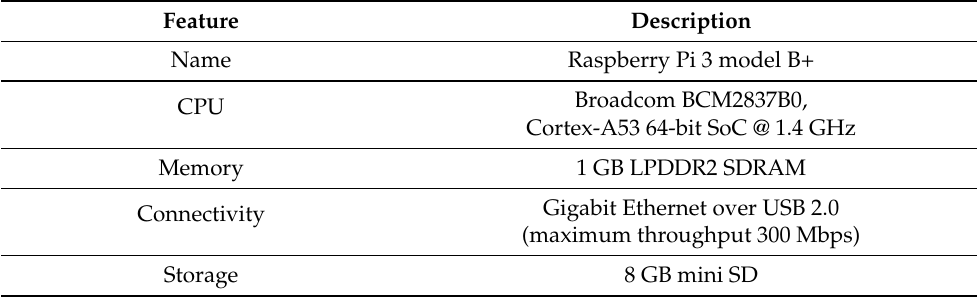
Table 4. Specifications of Raspberry Pi 3 model B+.